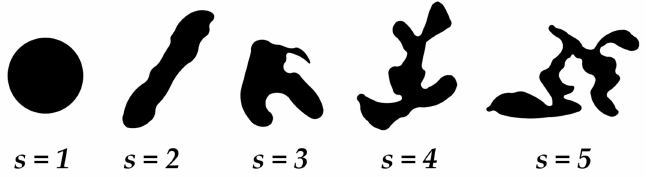
Figure 3. Numerical values of roundness factor “ s ” assigned to pore